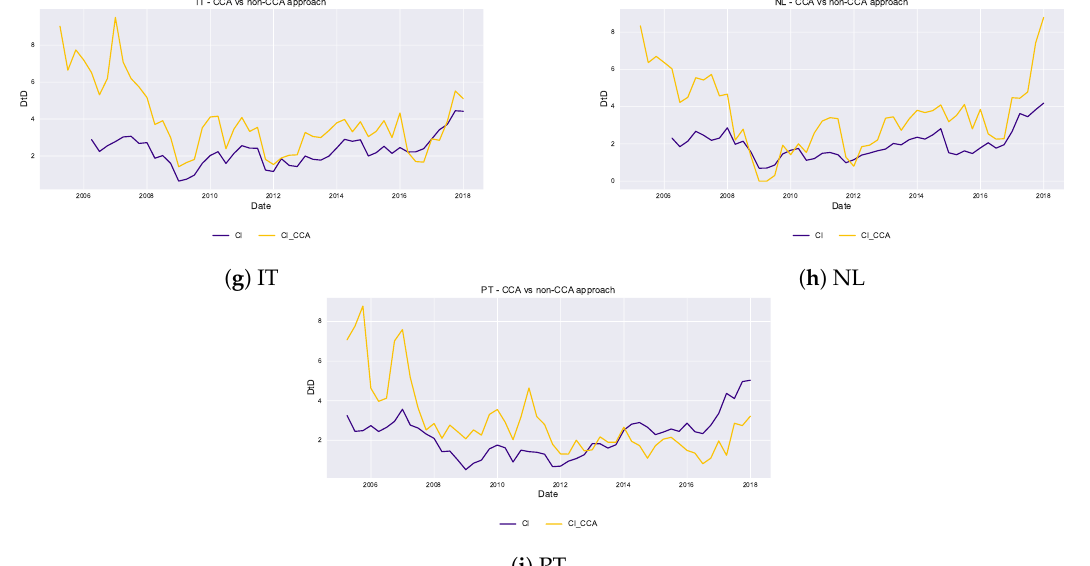
Figure 4. Banking sector DtD s comparison between CCA and non-CCA approach. The panels show the level of DtD for the CI sector of each country given the two possible approaches to compute it: the yellow line refers to the usual use of CCA while the blue line refers to the new methodology proposed in the paper. The y-axis expresses the DtD measure in standard deviations.—For Slovenia, the comparison was not possible due to lack of market data for the